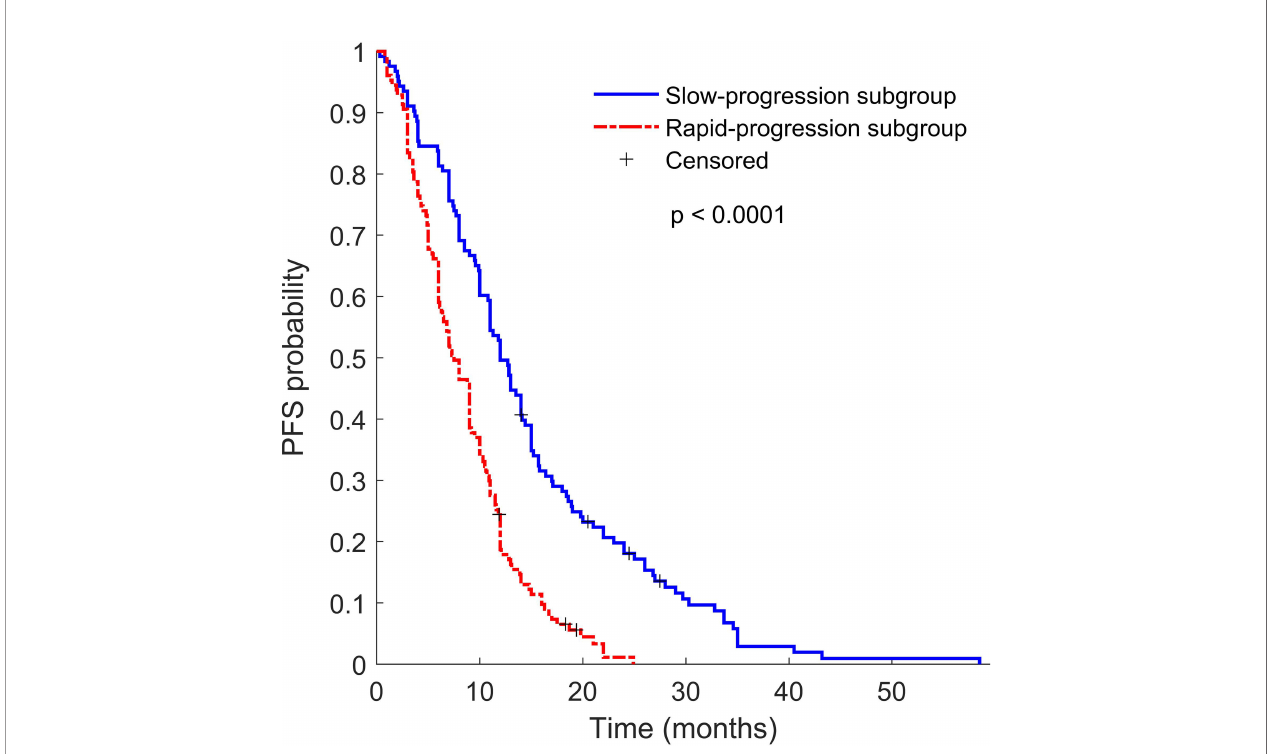
FIGURE 3 | Kaplan – Meier survival curves of slow progression subgroup TKI patients (blue line) and rapid progression subgroup TKI patients (red line). P value was calculated using the log-rank